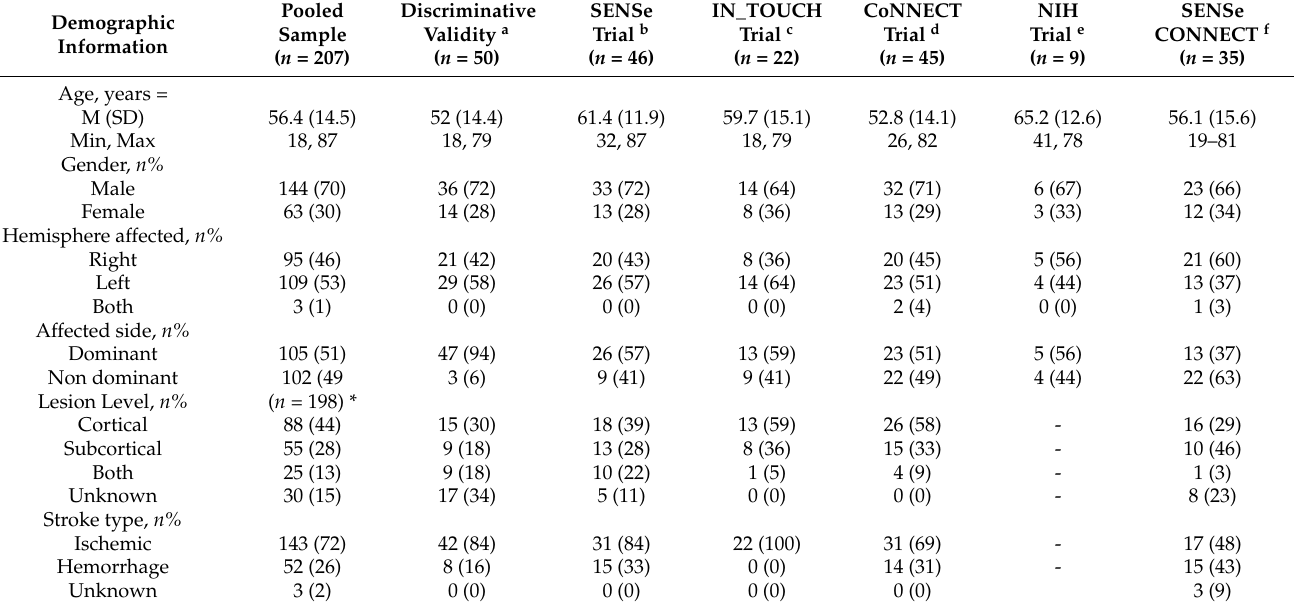
Table 1. Demographic characteristics of stroke survivors from pooled and individual study samples.